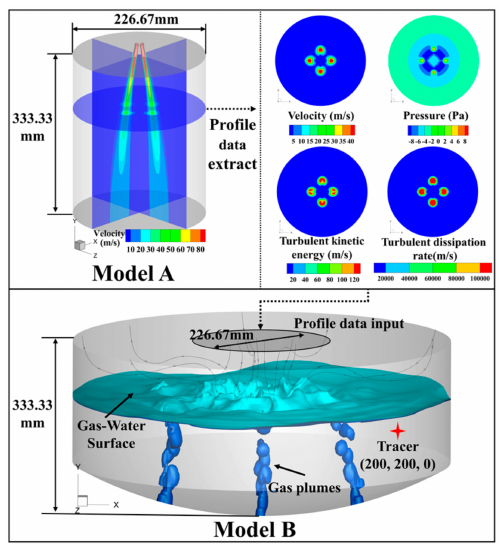
Figure 2. Schematic diagram of the numerical